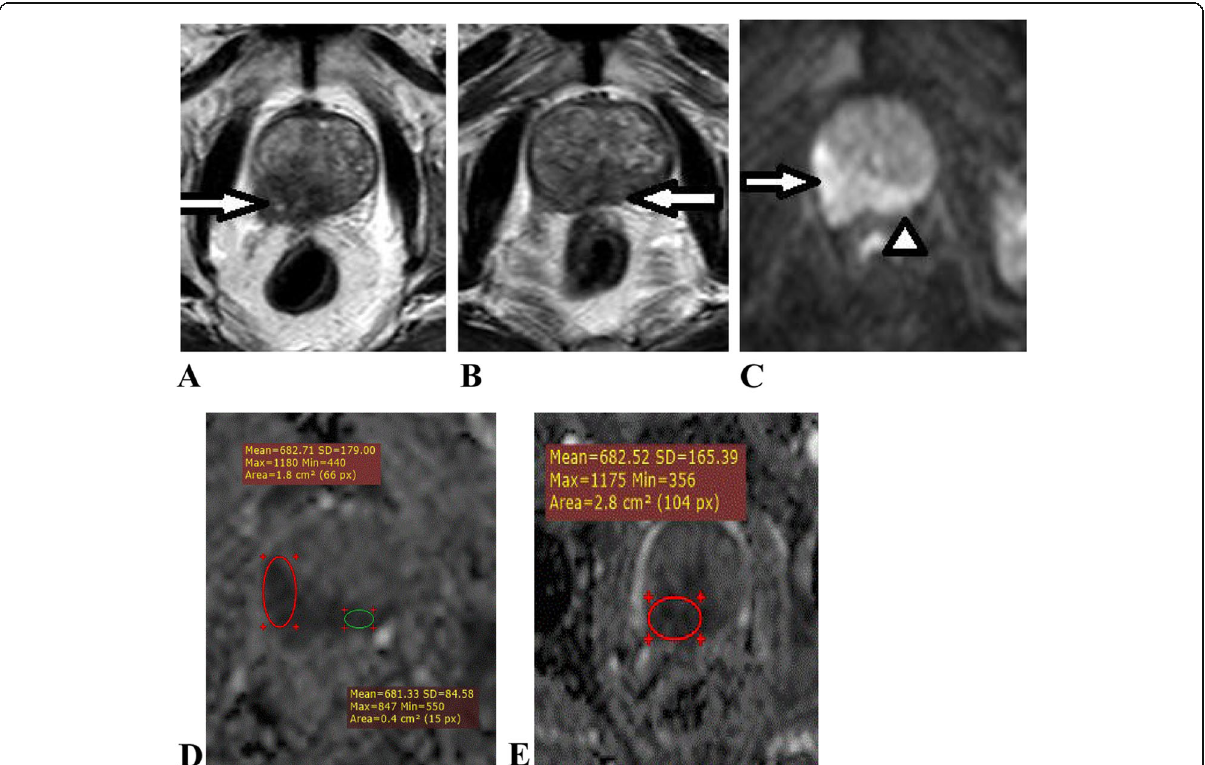
Fig. 7 A 75-year-old male patient with total PSA 91 with concordant interpretation in terms of PIRADSv2 DWI score. a , b Axial T2 showing bilateral peripheral zone low signal intensity lesions with extra prostatic extension with right neurovascular bundle involvement. c DWI (at b value 600) showing bright signal of the lesions. d , e ADC map images showing marked low signal intensity of the lesions with mean ADC value 0.682. The DWI score was 5 for readers 1 and 2. The ADC ratio between benign prostatic tissues was 1.868. Histopathology was adenocarcinoma GS 5 + 4 = 9; tumor volume = 1.9 cm 3 ; organ-confined)